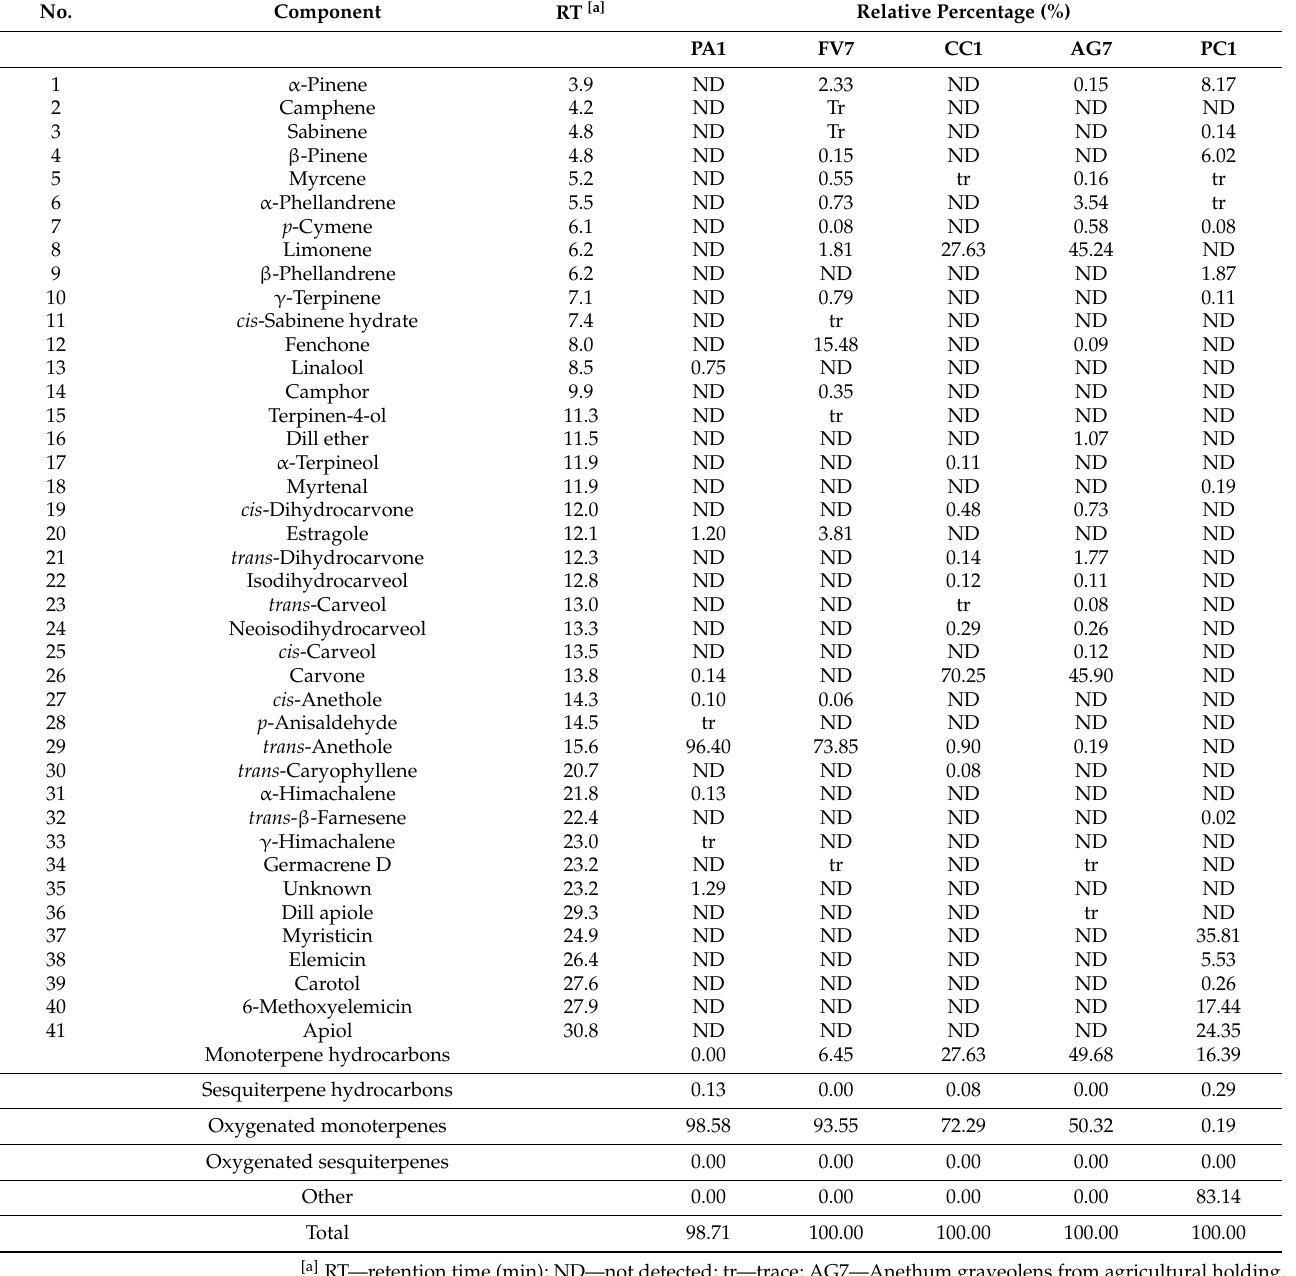
Table 4. GC-MS profile of EOs obtained from Apiaceae